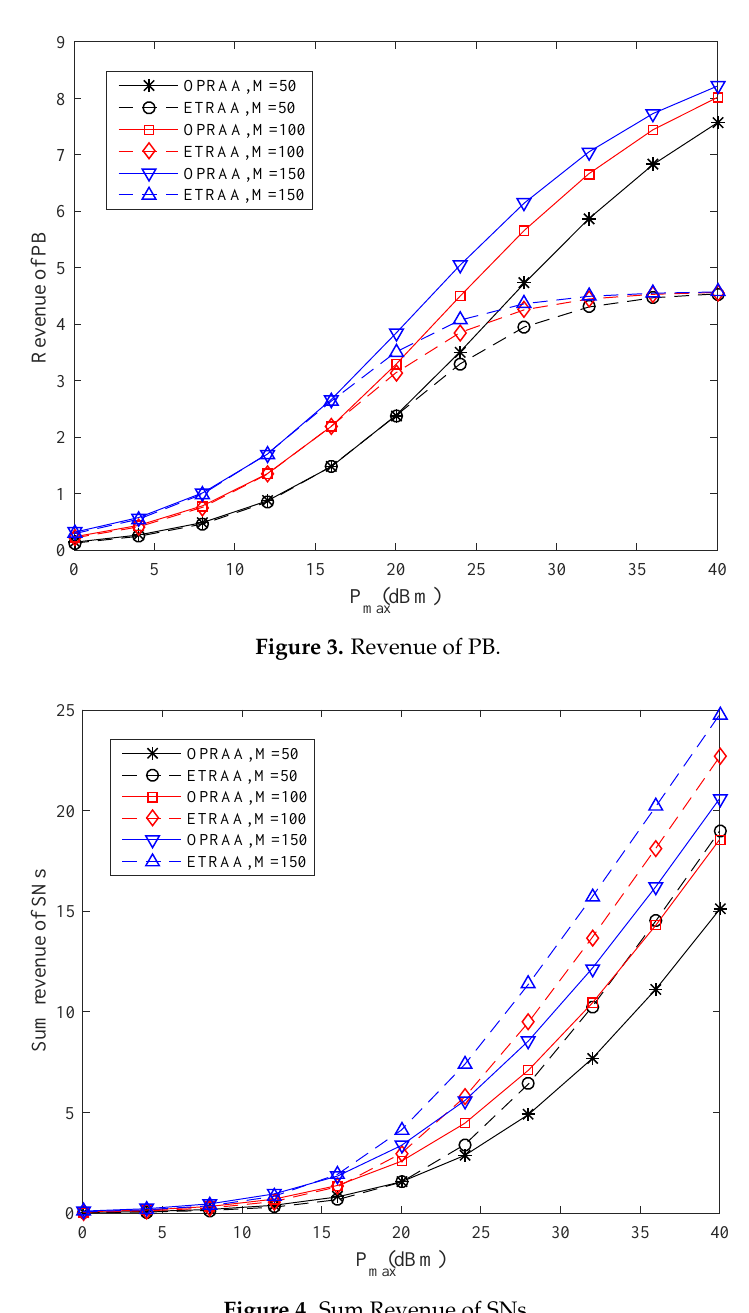
Figure 4. Sum Revenue of